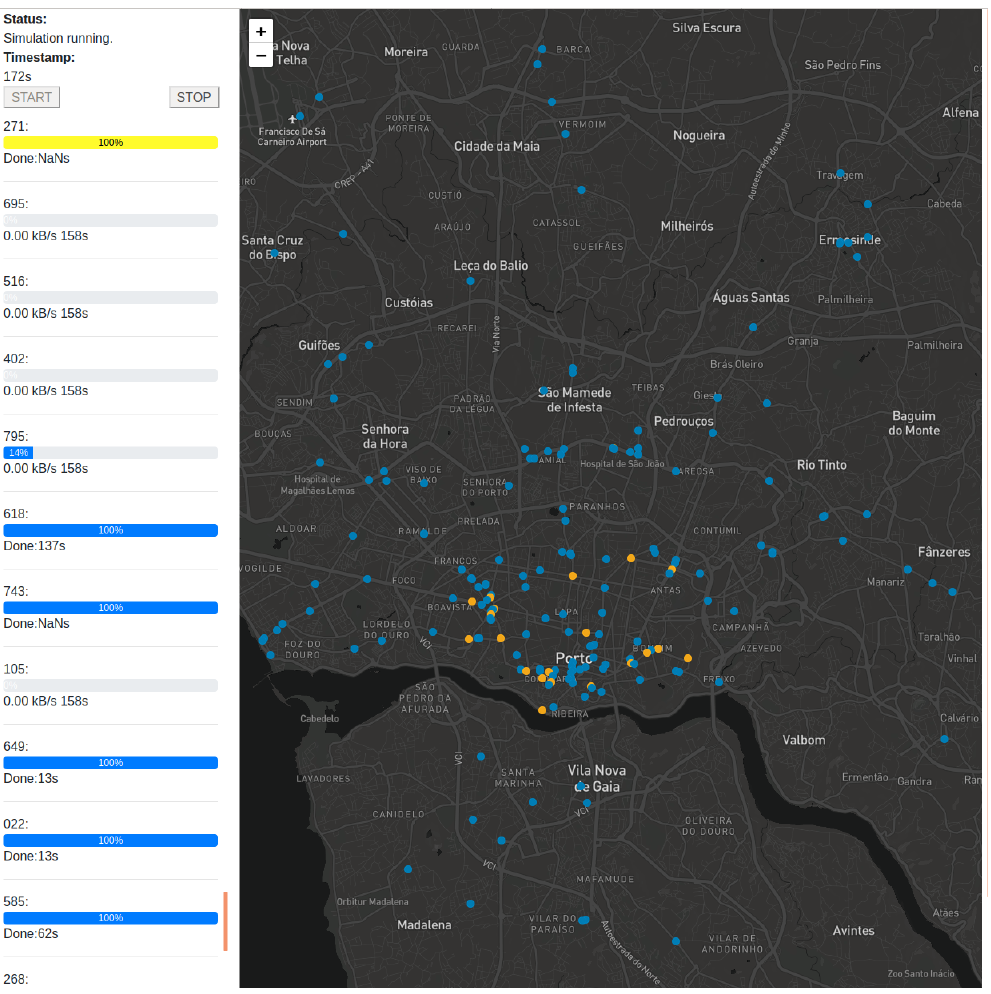
Figure 14. Frontend of the network emulator running a scenario with 200 nodes in